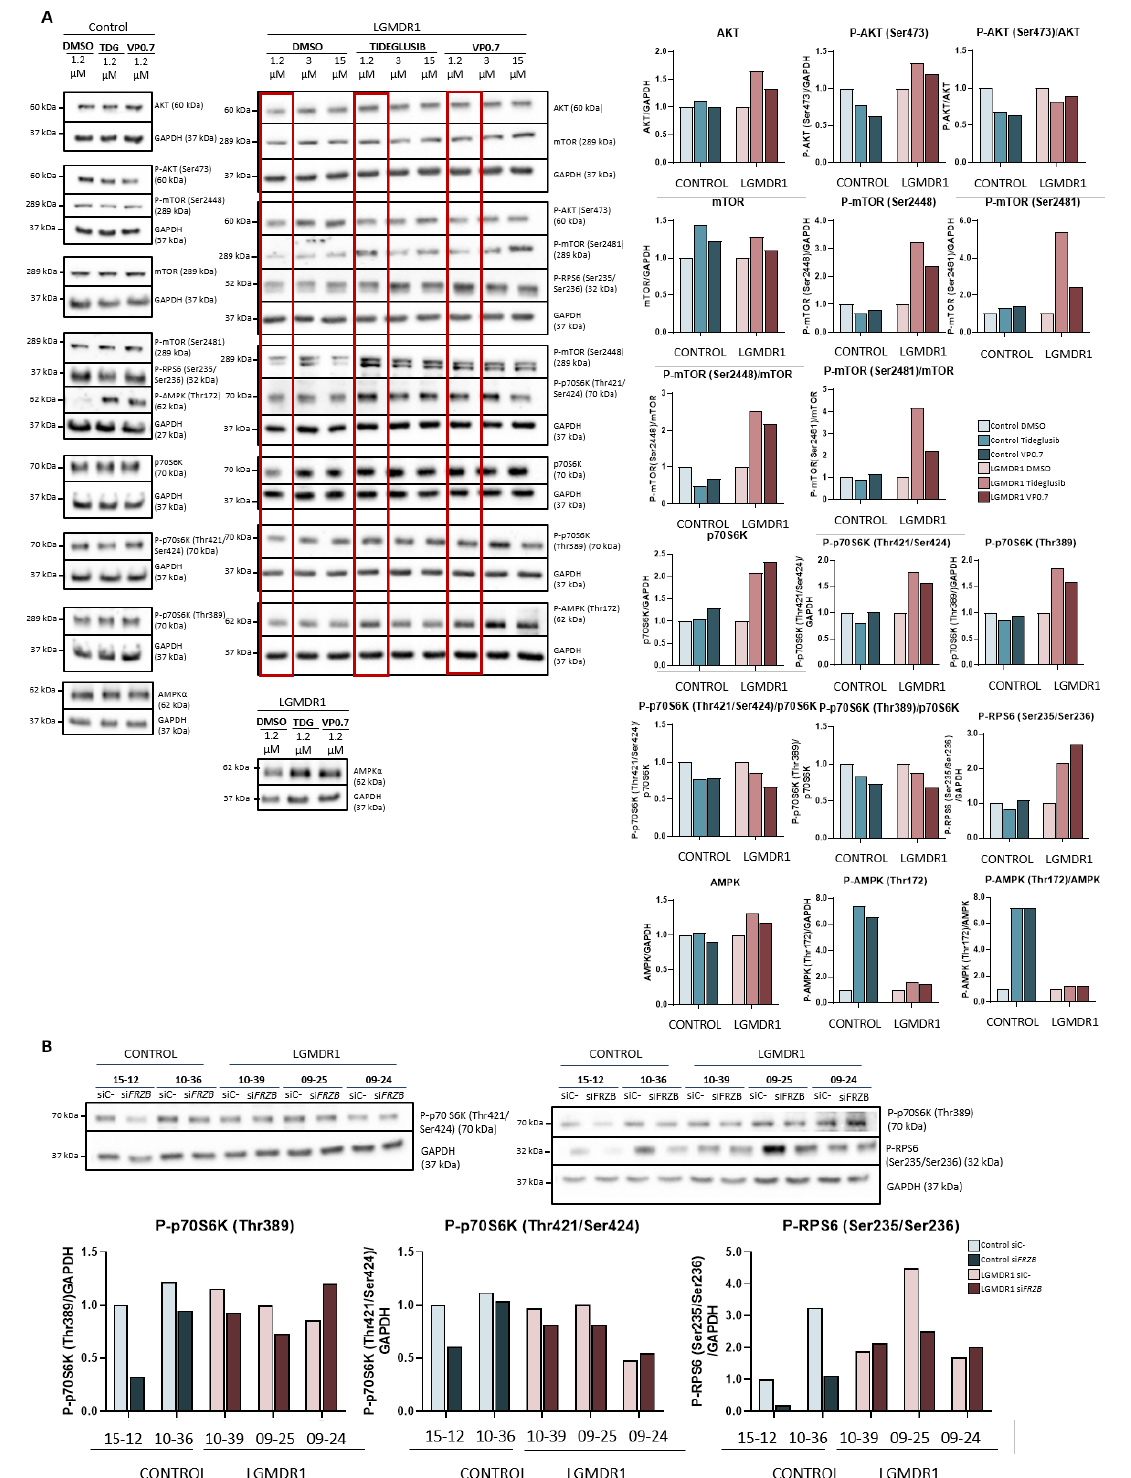
Figure 5. Activation of the Akt/mTOR pathway in human myotubes on day 8 of differentiation and after 48 h of treatment with tideglusib and VP0.7 at three concentrations (1.2, 3.0 and 15.0 µ M) in control ( n = 1) and patient LGMDR1 ( n = 1): ( A ) western blot of AKT, P-AKT (Ser473), mTOR, P-mTOR (Ser2448 and Ser2481), p70S6K, P-p70S6K (Thr421/Ser424), P-p70S6K (Thr389), P-RPS6 (Ser235/Ser236) and P-AMPK (Thr172). ( B ) Effect of FRZB silencing on the mTOR pathway in controls’ ( n = 2) and LGMDR1 patients’ ( n = 3) myotubes. The red squares in the WB show the lowest concentration used in patients (1.2 µ M) for densitometry analysis. For the quantification of total AMPK α in LGMDR1 patient’s myotubes, only the lowest dose was